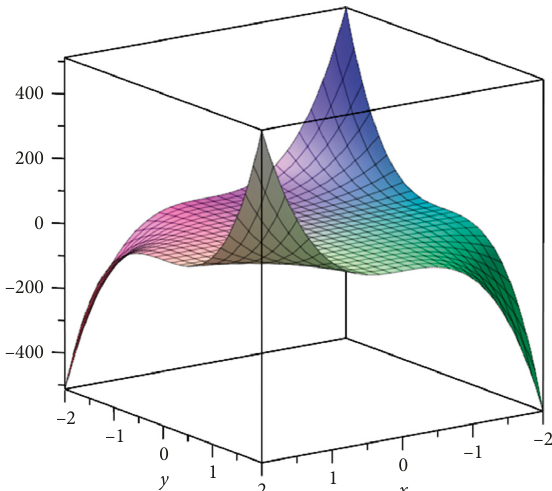
Figure 2: The graph of the M-polynomial of O